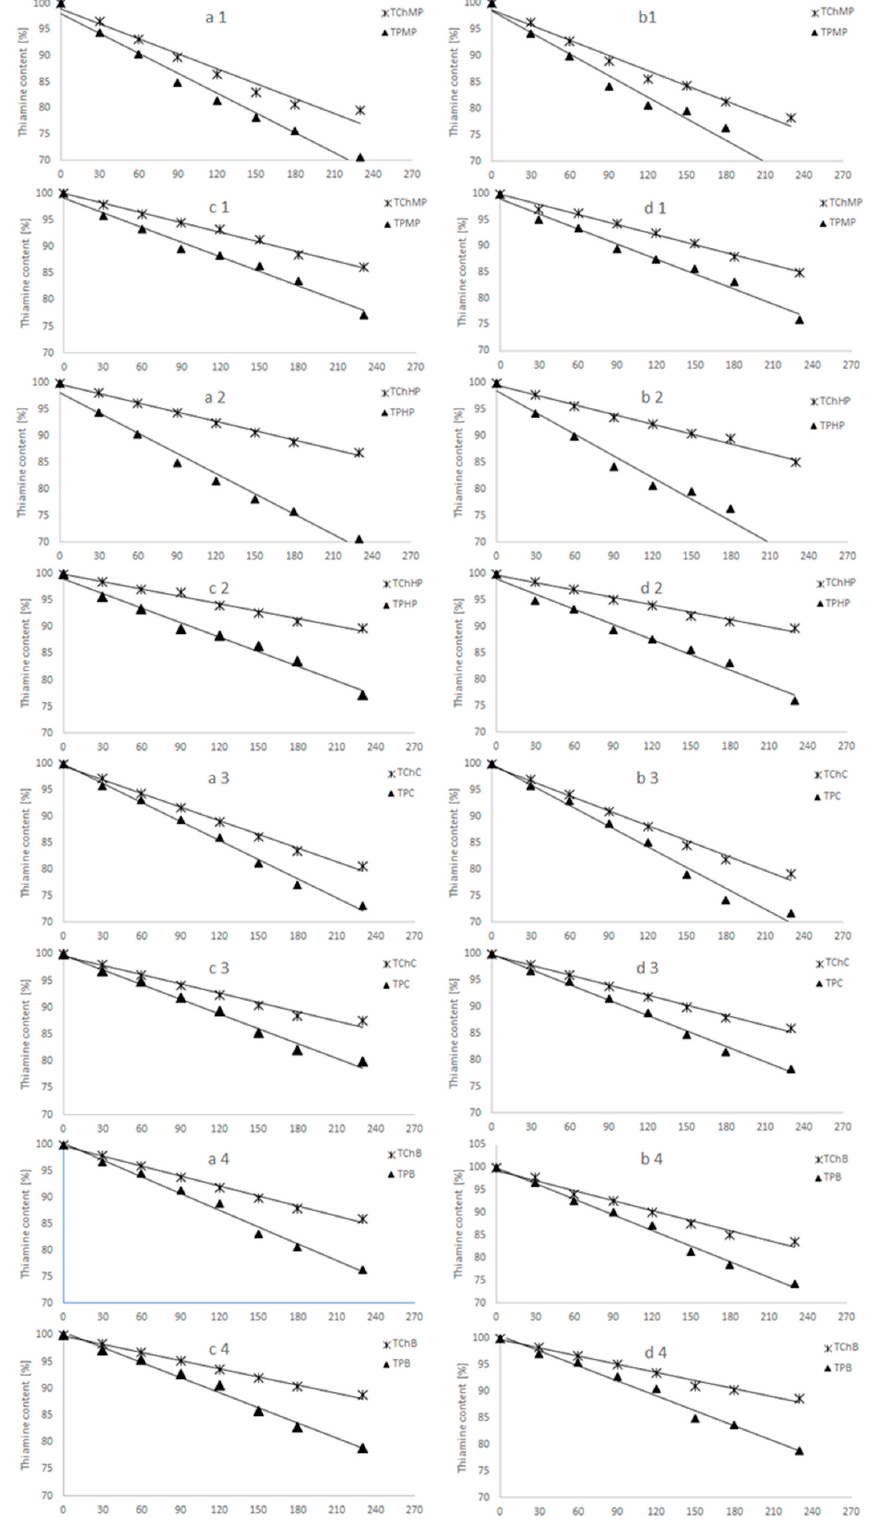
Figure 1. Thiamine content [%] in carriers: Muscat Pumpkin (1), Hokkaido Pumpkin (2), Cauliflower (3), Broccoli (4) of thiamine hydrochloride and thiamine pyrophosphate stored during 230 days in the presence of different storage conditions (a—40 °C and restriction of light; b—40 °C and access to light; c—21 °C and restriction of light; d—21 °C and access to light).